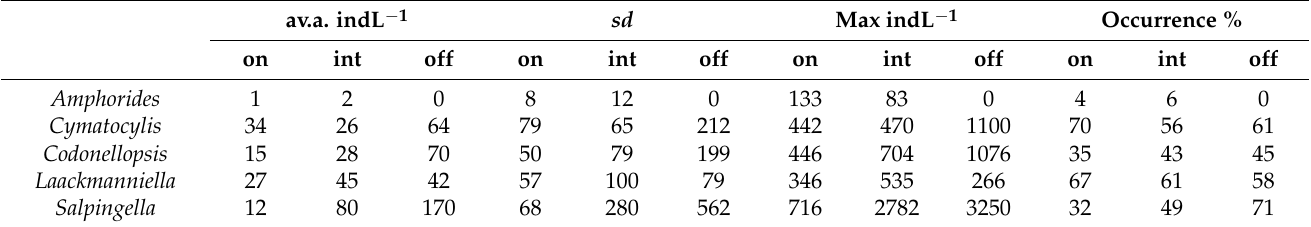
at more than 50 km from the coastline (off), during the study period.